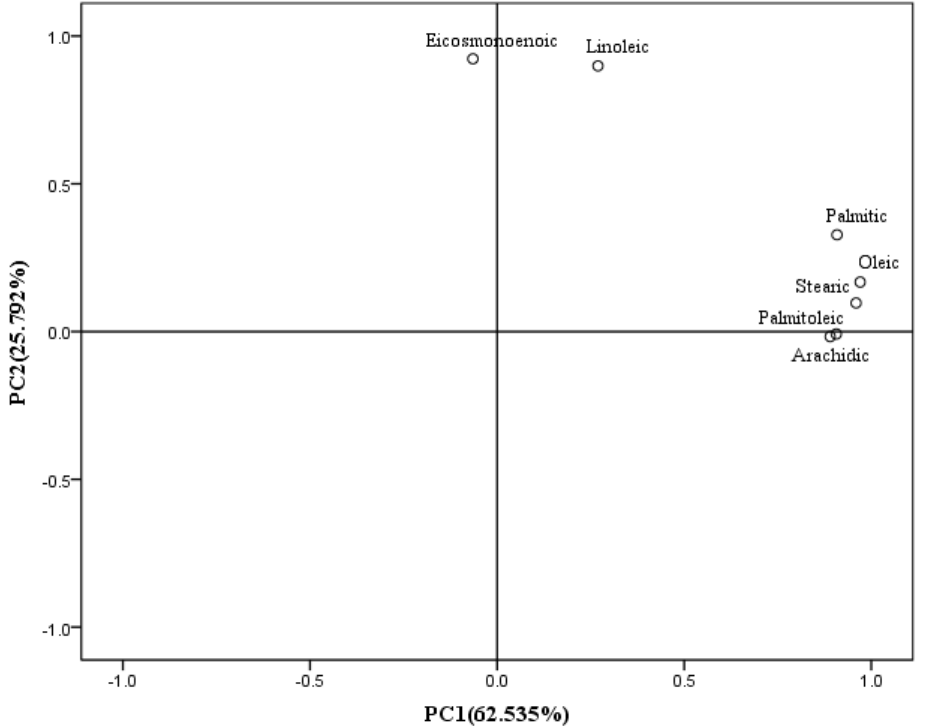
Figure 1. Rotation loading diagram of the fatty acid principal component analysis of fresh sweet and glutinous maize.